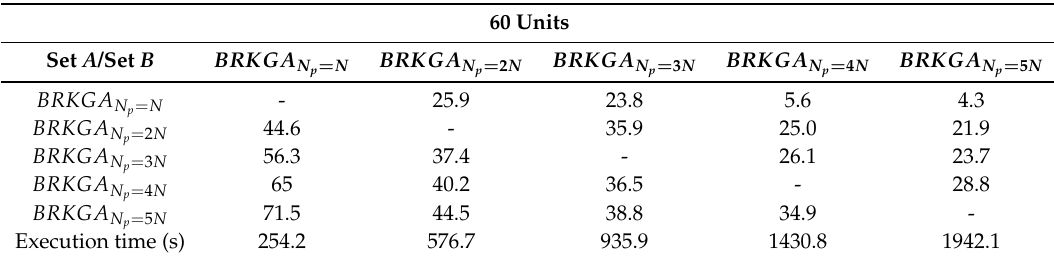
Table 4. Percentage of Non-dominated Solutions of set B covered by those in set A for case study 1 with pc = 0.7.